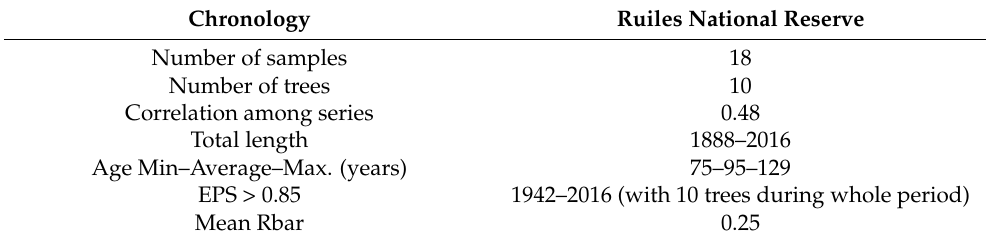
Table 1. Descriptive statistics of the residual chronology of the studied Nothofagus alessandrii